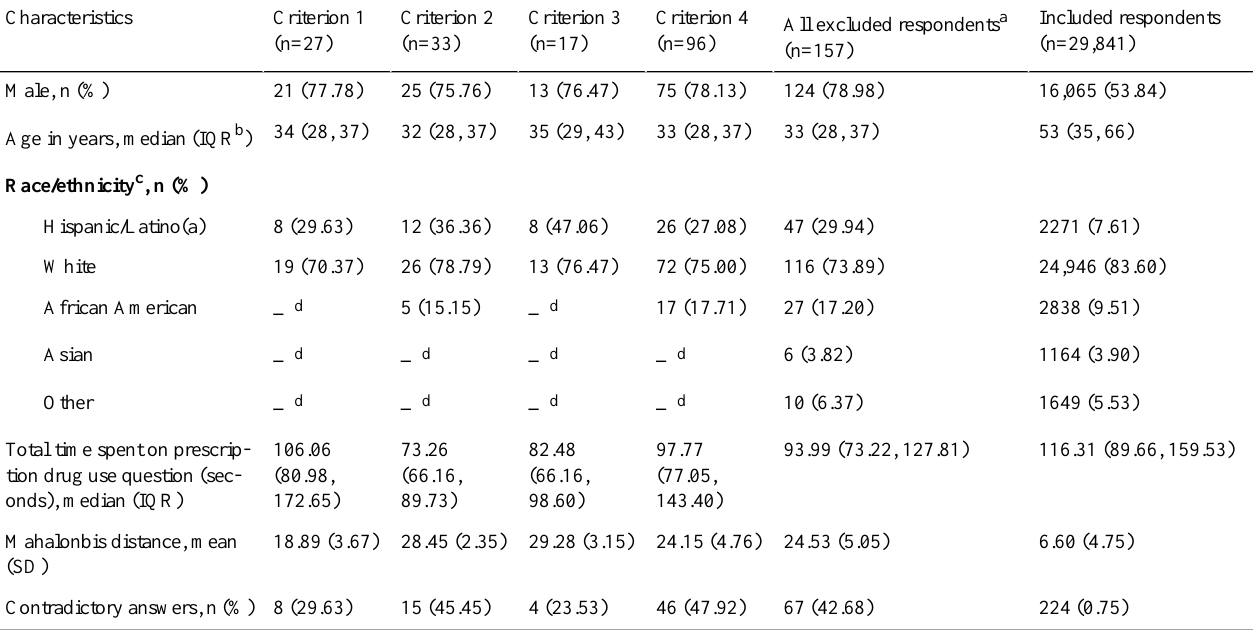
Table 1. Respondent characteristics of excluded and included